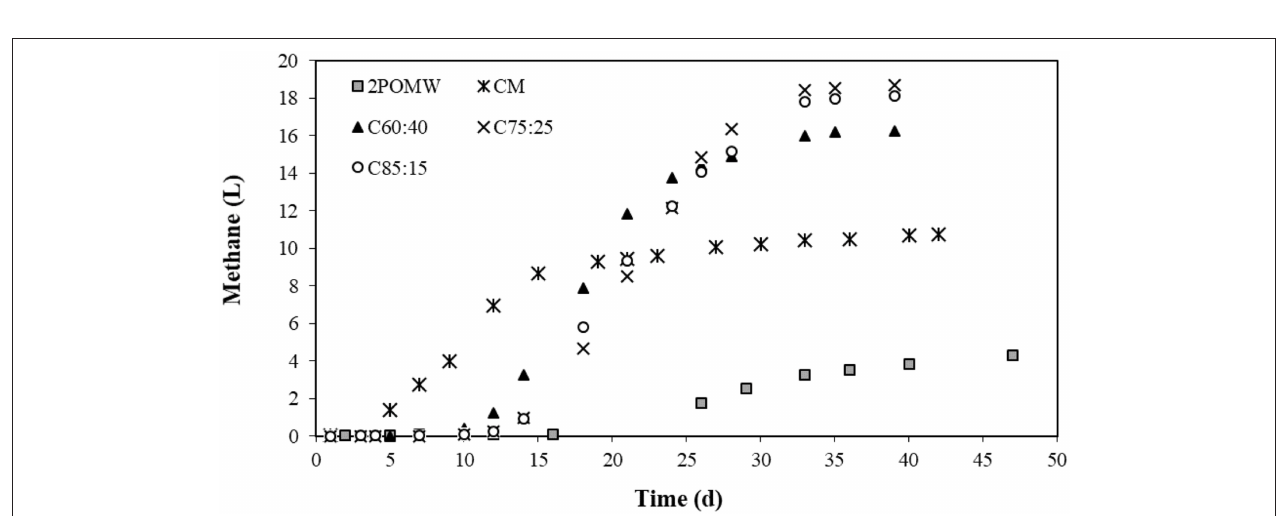
FIGURE 5 | Cumulative methane production for 2POMW, CM and co-digestion mixtures in batch experiments.